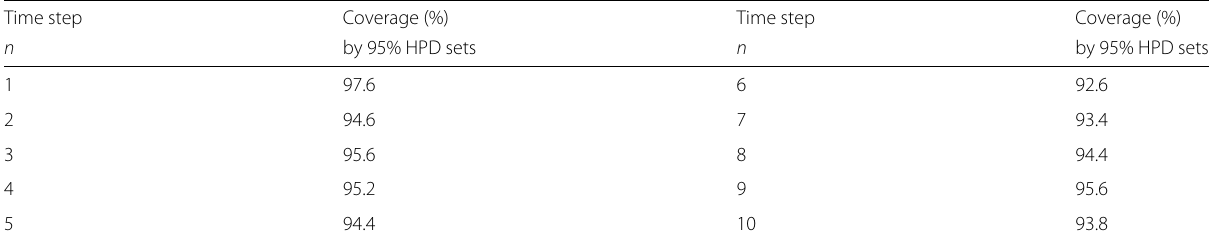
Coverage probabilities are shown for each n in Example 1 corresponding to ( Q , R ) = ( 0.2,0.1